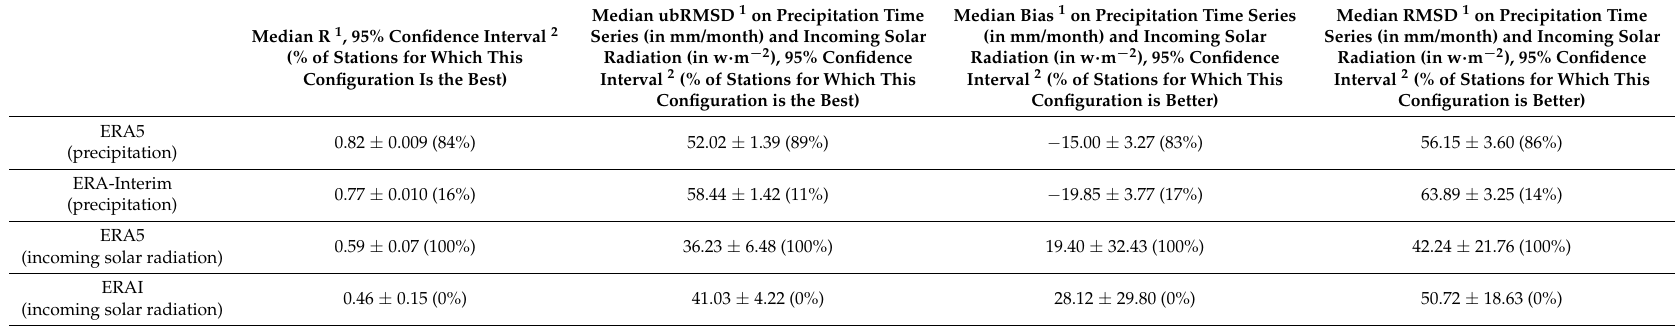
Table 2. Comparison of precipitation and incoming solar radiation forcing with in situ observations for ERA5 and ERA-Interim over the period of 2010–2016 (based on monthly sum). Scores are given for significant correlations with p -values <